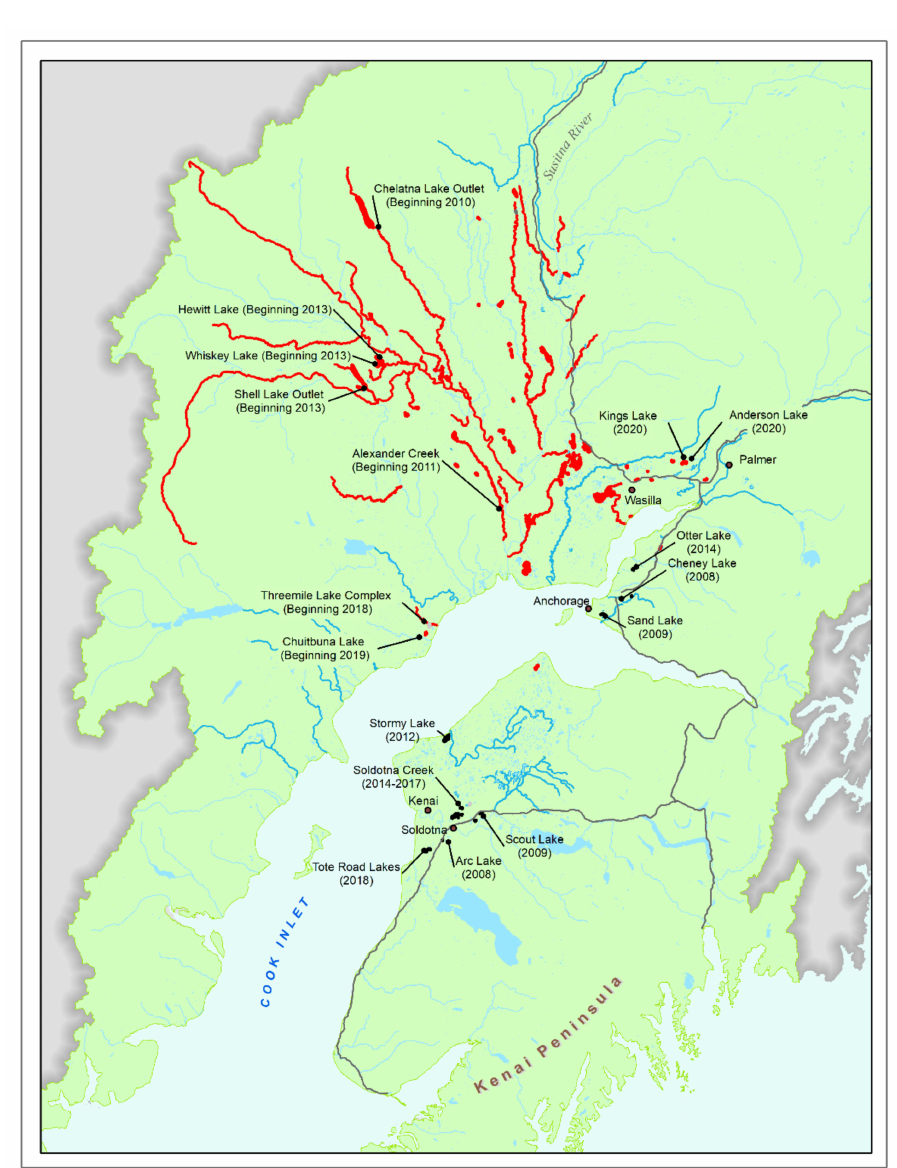
Figure 4. Drainages with pike populations (red). Pike suppression locations noted by year projects were initiated. Pike eradication locations noted by year project was